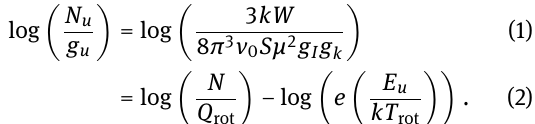
Figure 2. Example of a transition without hyperfine structure. Note: at this scale the upper and lower limit coincide with the synthetic spectrum.